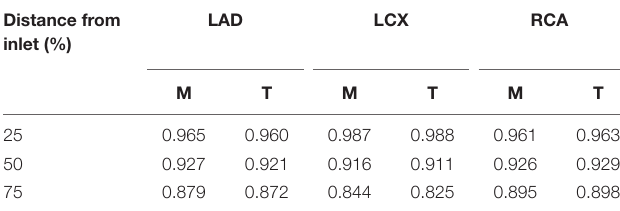
TABLE 2 | Computed FFR for manual (M) and template (T)